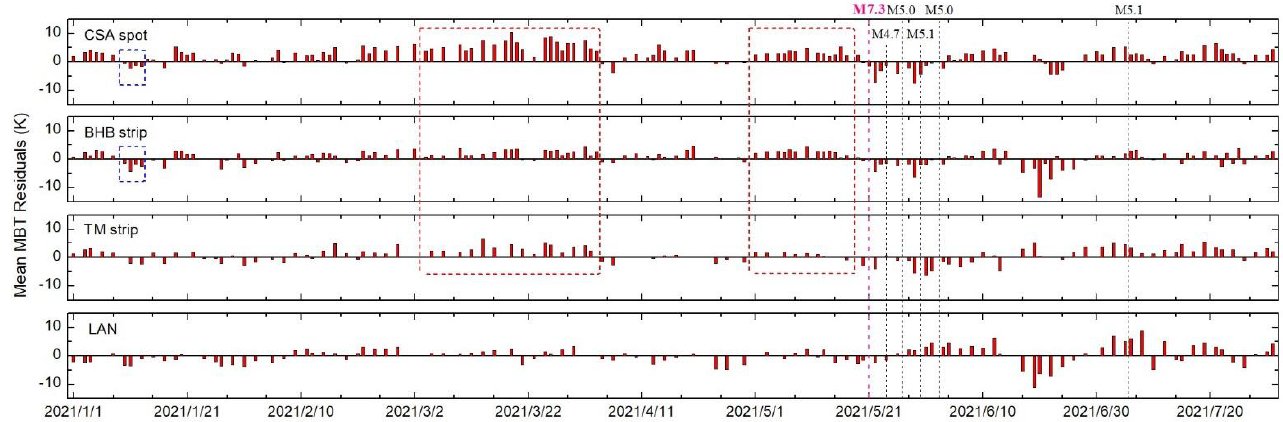
Figure 5. Time series of average residuals (10.65 GHz at H polarization) in the areas of four typical abnormal MBT defined in Figure A1 from January to July, 2021.